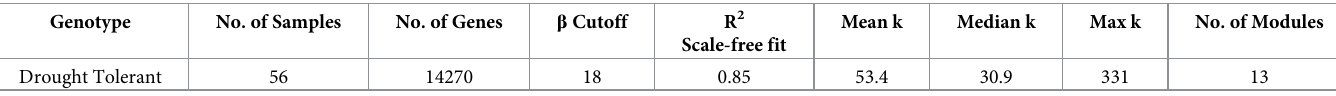
Table 2. Parameters for the construction of signed, weighted gene co-expression network is summarized. Genotype No. of Samples Drought